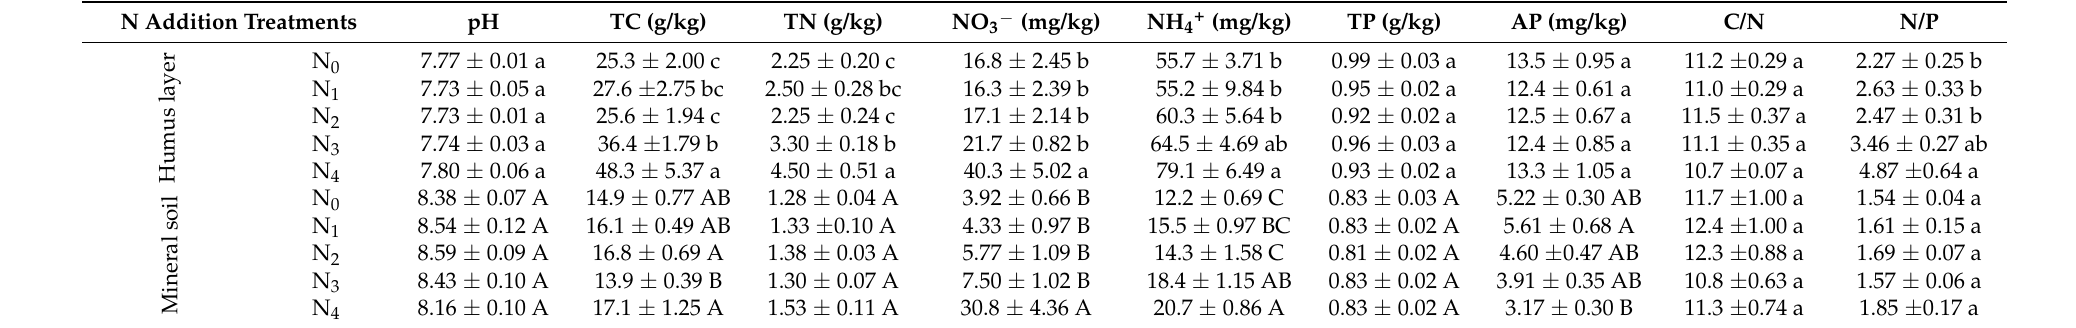
means ± SE ( n = 4). Different letters indicate significant differences between means (Tukey’s HSD pairwise